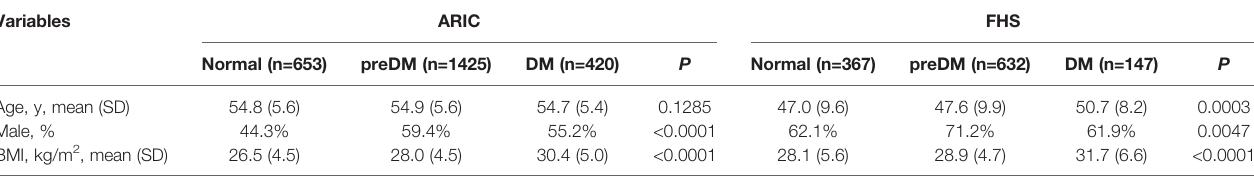
TABLE 1 | Baseline characteristics of the ARIC and FHS participants by follow-up diabetes status. Variables